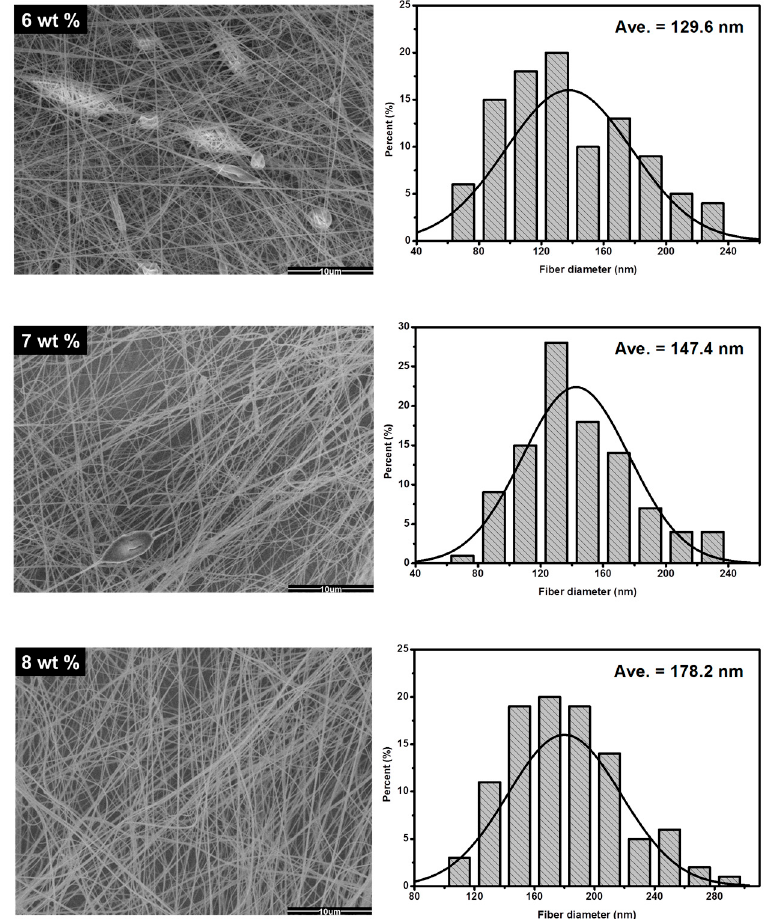
Figure 1. SEM (scanning electron microscope) micrographs and diameter distributions of solution blown parallel coaxial nozzles (PAA) nanofibers at different polymer concentration. The solution feeding rate, gas pressure, inner nozzle diameter and receiving distance were fixed as 2.4 mL/h, 0.08 MPa, 0.4 mm and 20 cm, respectively. (Ave. indicated the average diameter of